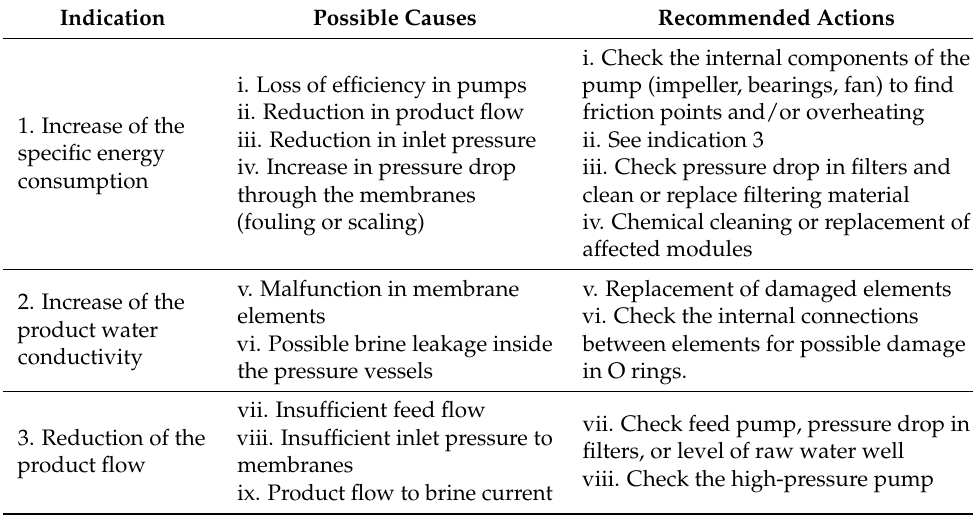
Table 7. Most common operation issues in RO plants.